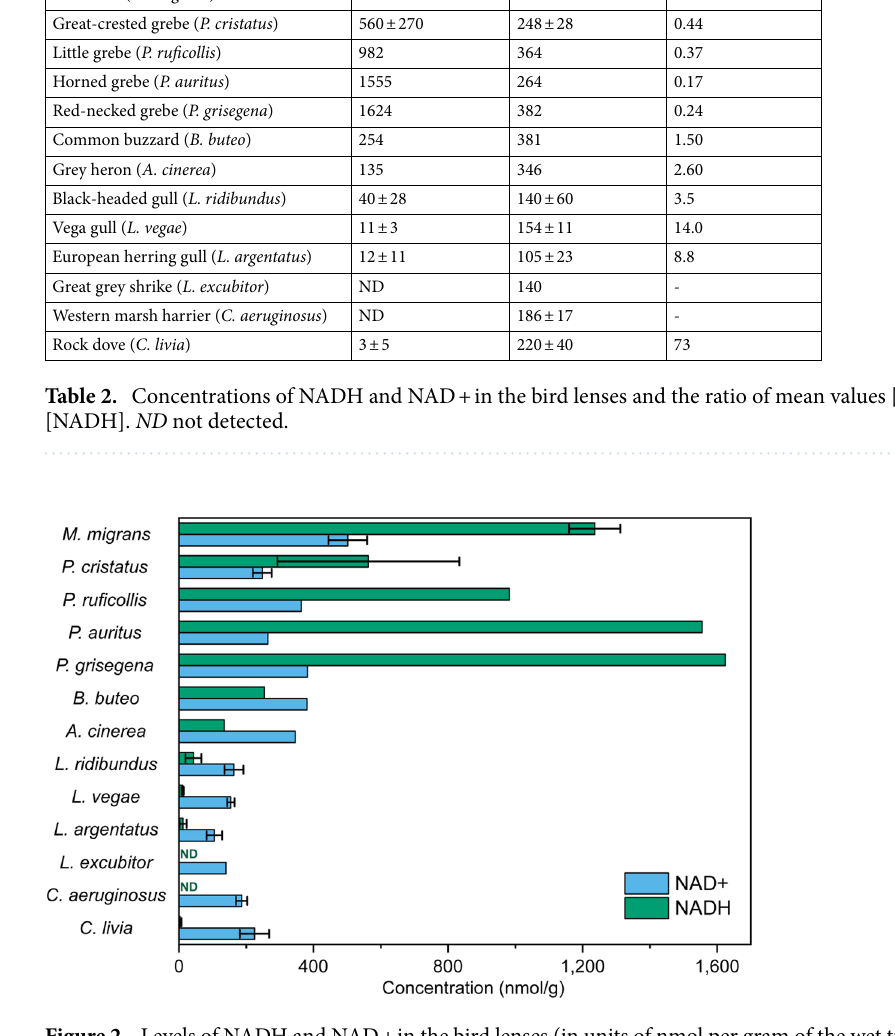
Figure 2. Levels of NADH and NAD + in the bird lenses (in units of nmol per gram of the wet tissue). ND not